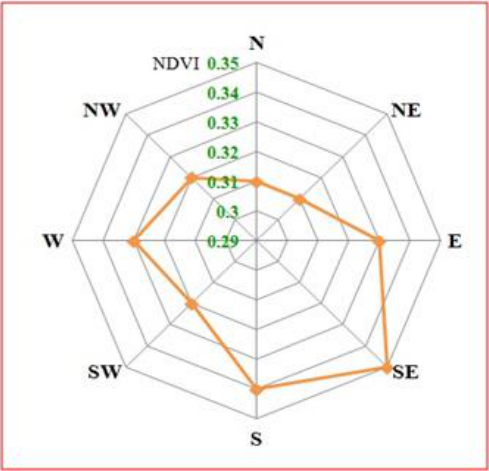
Figure 4. Change in NDVI value with altitude Healthy vegetation is represented by high NDVI values between 0.1 and 1. Inversely, non-vegetated surfaces such as water bodies yield negative values of NDVI because of the electromagnetic absorption quality of water. Bare soil areas represent NDVI values which are closest to 0 due to high reflectance in both the visible and NIR portions of the EMS (Lilles and Kiefer 1994). The NDVI value change with aspect is shown in figure 5.